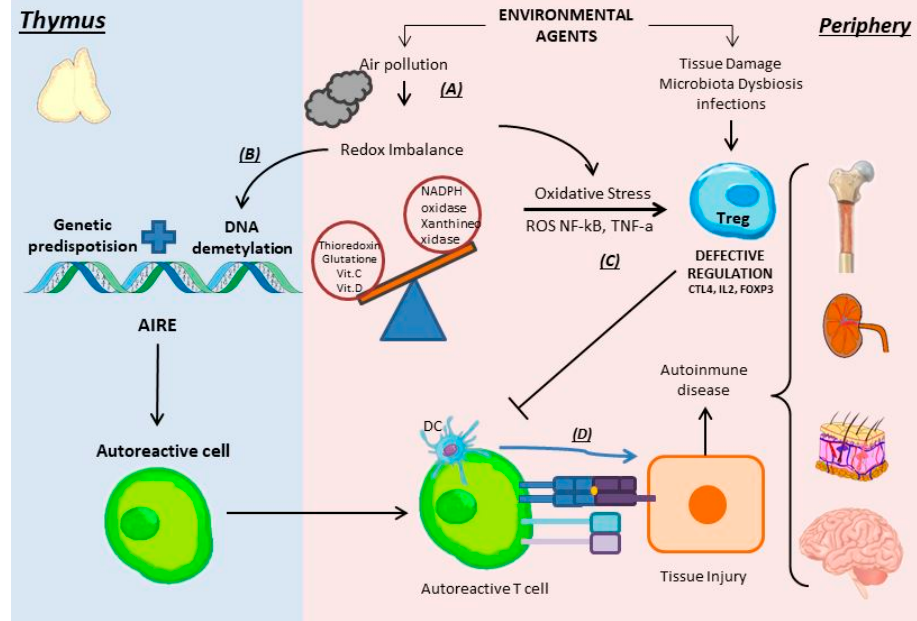
Figure 4. The redox imbalance in autoimmunity. ( A ) Environmental pollution induces a redox imbalance, with an increase in oxidizing enzymes (NADPH and xanthine oxidase) and a decrease in antioxidants (thioredoxin, glutathione, vitamins C, and D). ( B ) The redox imbalance generates DNA demethylation. ( C ) Oxidative stress (through ROS, NF-kB, TNF- α ) modifies Tregs, reducing their regulatory capacity. ( D ) The autoreactive lymphocyte survives, proliferates, and damages the tissue generating autoimmune disease.